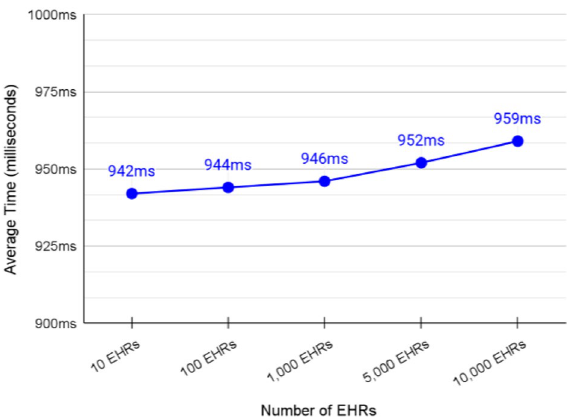
Figure 15. Average transaction speed of adding a specific patient’s EHR to the cache shard.